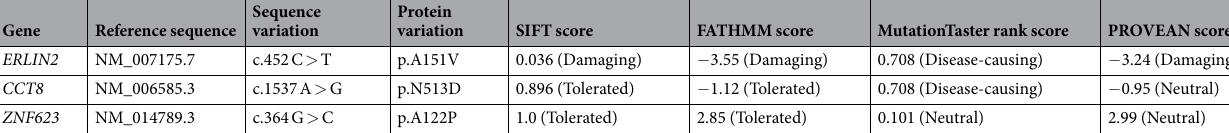
Table 3. Prediction of the pathogenic effect of candidate